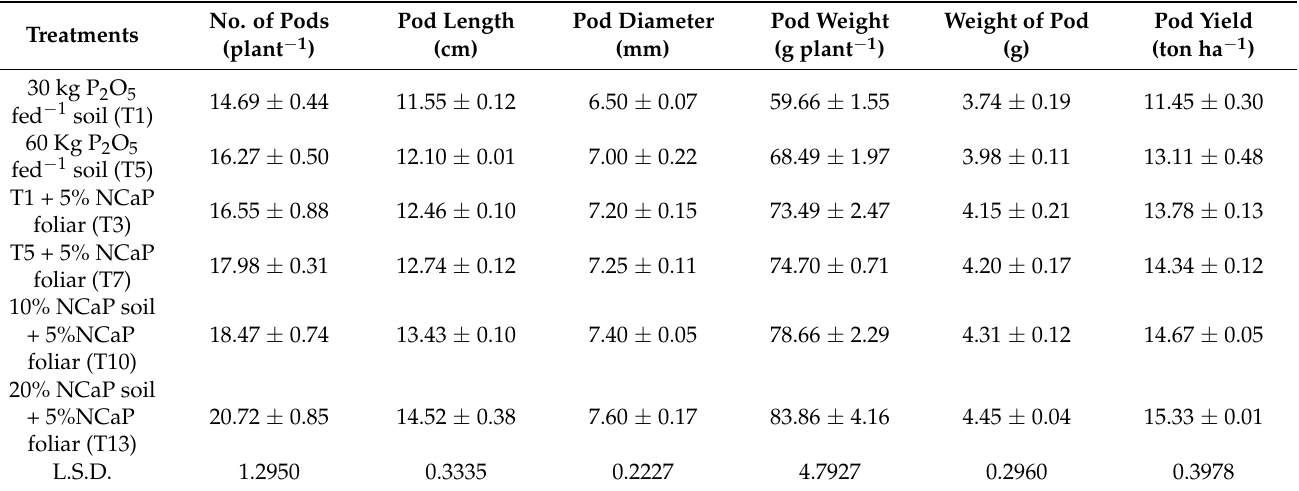
Table 6. Effect of different phosphorus testaments on yield and its components of snap bean plants.